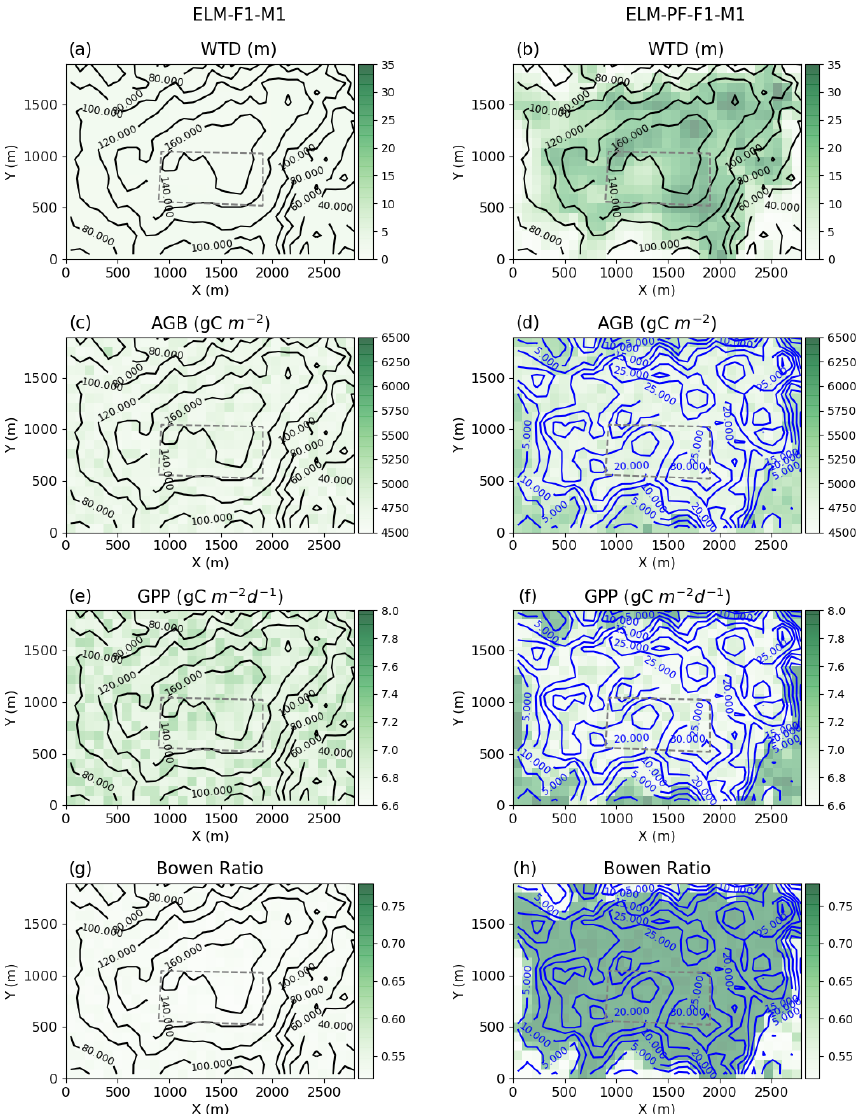
Figure 3. Sensitivity of model predictions to lateral flow dynamics and water table depth. Water table depth (WTD) (a, b) , aboveground biomass (AGB) (c, d) , GPP (e, f) , and Bowen ratio (g, h) for ELM-F1-M1 (no lateral flow) and ELM-PF-F1-M1. The blue contour lines in (d) , (f) , and (h) are WTD, and the black contour lines in the rest are ground surface elevation (m). The 50ha plot is located in the region within the dashed